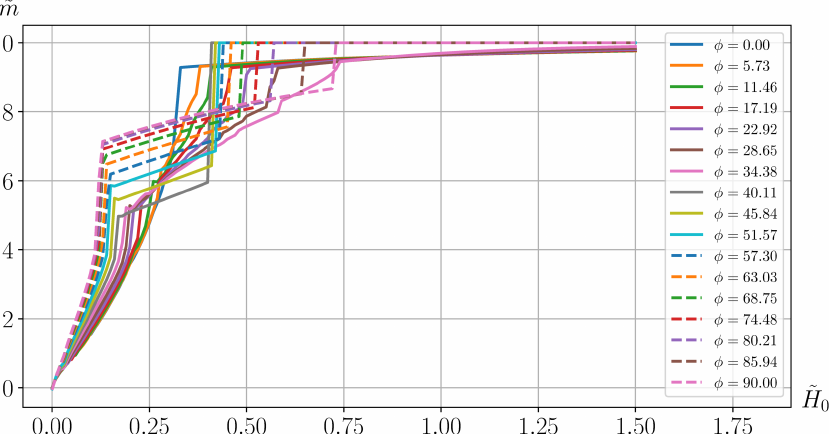
Figure 7. The magnetization curves for different directions of application of external magnetic field φ (in degrees), taking into account possible